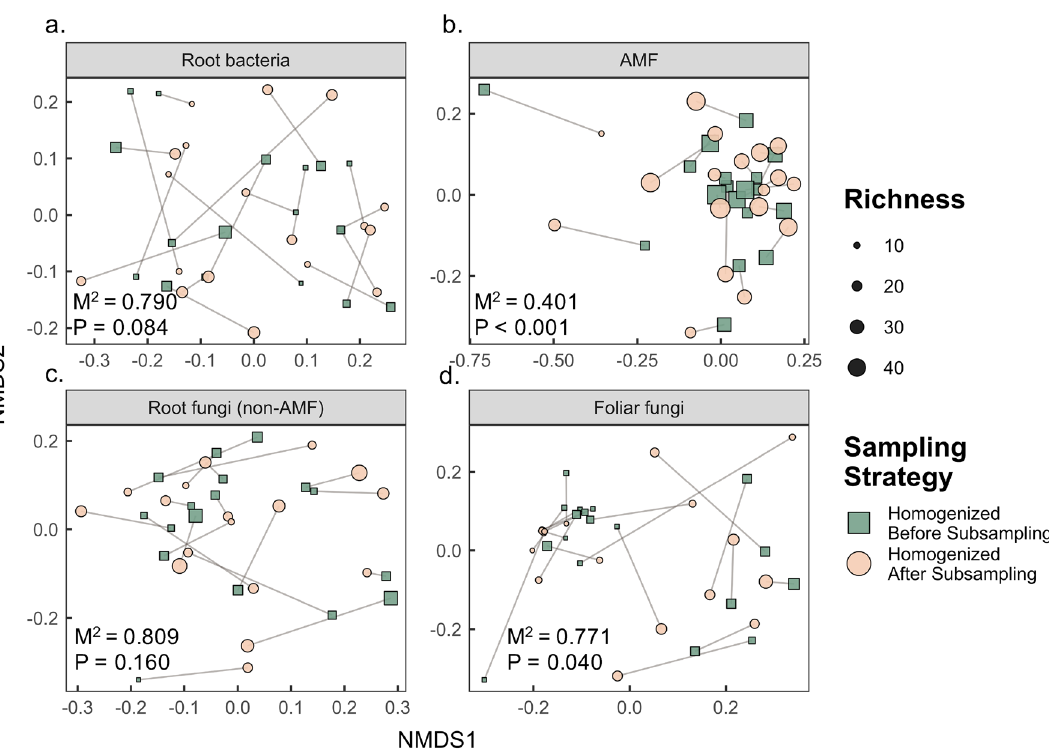
Figure 4. Procrustes plots comparing two different subsampling strategies used to characterize ( a ) root bacteria, ( b ) AMF, ( c ) non-AM root fungi, and ( d ) foliar fungi colonizing milkweed plants. Plots are based on non-metric multidimensional scaling of Bray–Curtis distance matrices of Hellinger transformed relative abundances. M 2 values represent the sum of squared deviations between sample pairs, where lower values indicate a better fit between